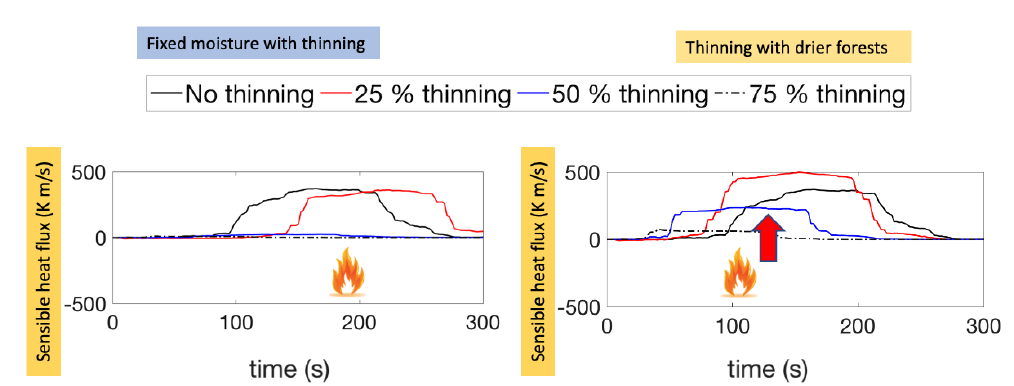
Figure 6. Sensible heat flux recorded at 15 level at domain centre as the fire propagates. Left panel shows the reference case and the three thinning cases with no change of canopy fuel moisture. Right panel shows the reference cases and the 3 thinning cases with lower canopy fuel moisture. The arrival of the fire front is shown with a fire